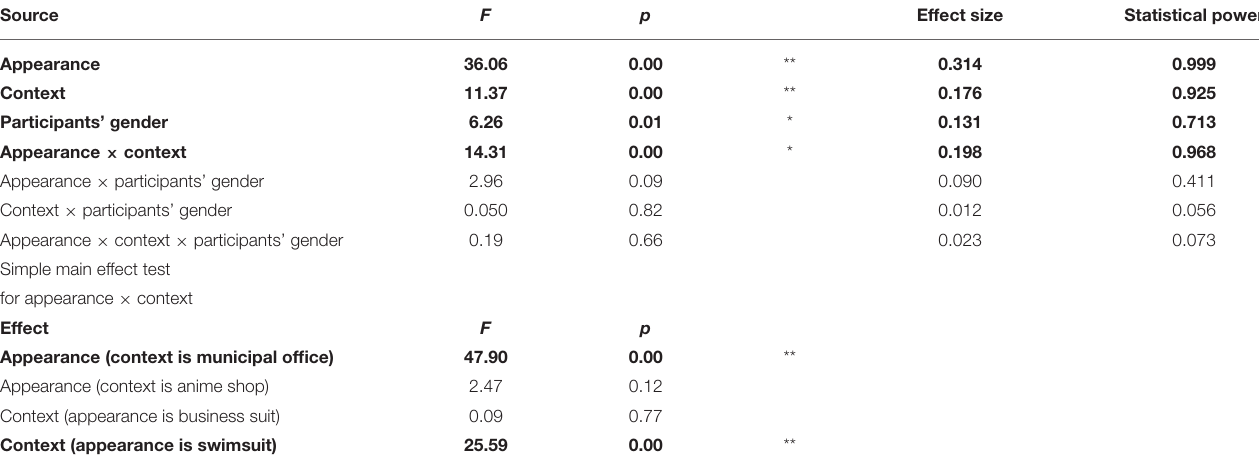
TABLE 10 | Results of three-way ANOVA simple main effect test for appearance × context for Q5 (suitability).